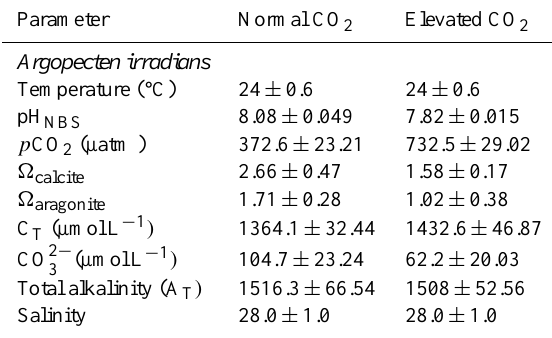
Table 5. Temperature, pH, carbonate chemistry, total alkalinity, and salinity (±1SD) during the four-level carbon dioxide experiments with Mercenaria mercenaria larvae for varying CO 2 exposure ex-